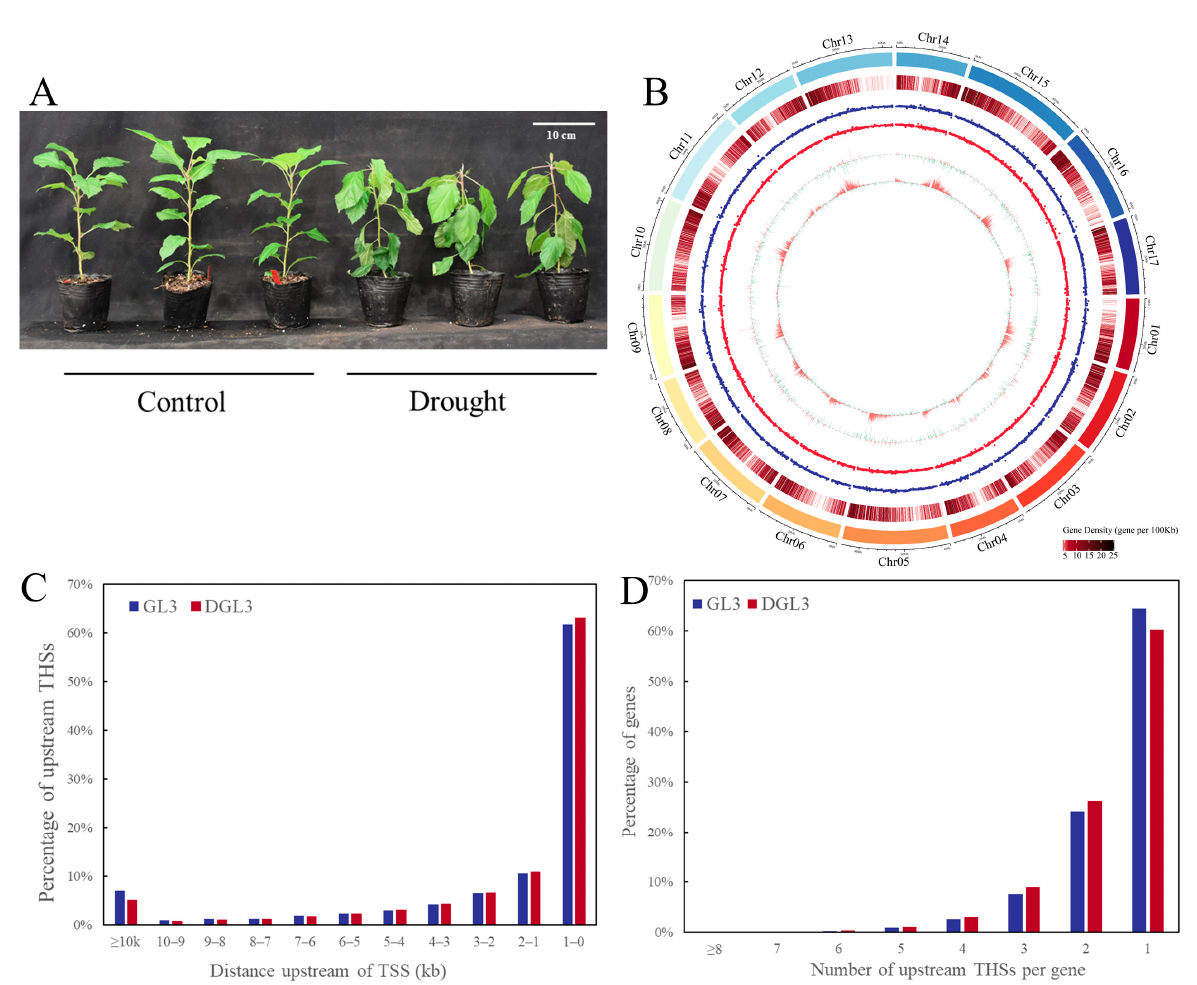
Figure 1. Plant phenotypes and characterization of ATAC-seq and RNA-seq data. ( A ) The phenotype of control and drought GL3. ( B ) Characteristics of ATAC-seq and RNA-seq, which are chromosome, gene density, distribution of GL3 ATAC data, distribution of DGL3 ATAC data, distribution of differential genes, and distribution of differential ATAC peaks from outside to inside. ( C ) The distribution of ATAC signals upstream of the gene TSS. ( D ) Number of ATAC signals upstream of genes.